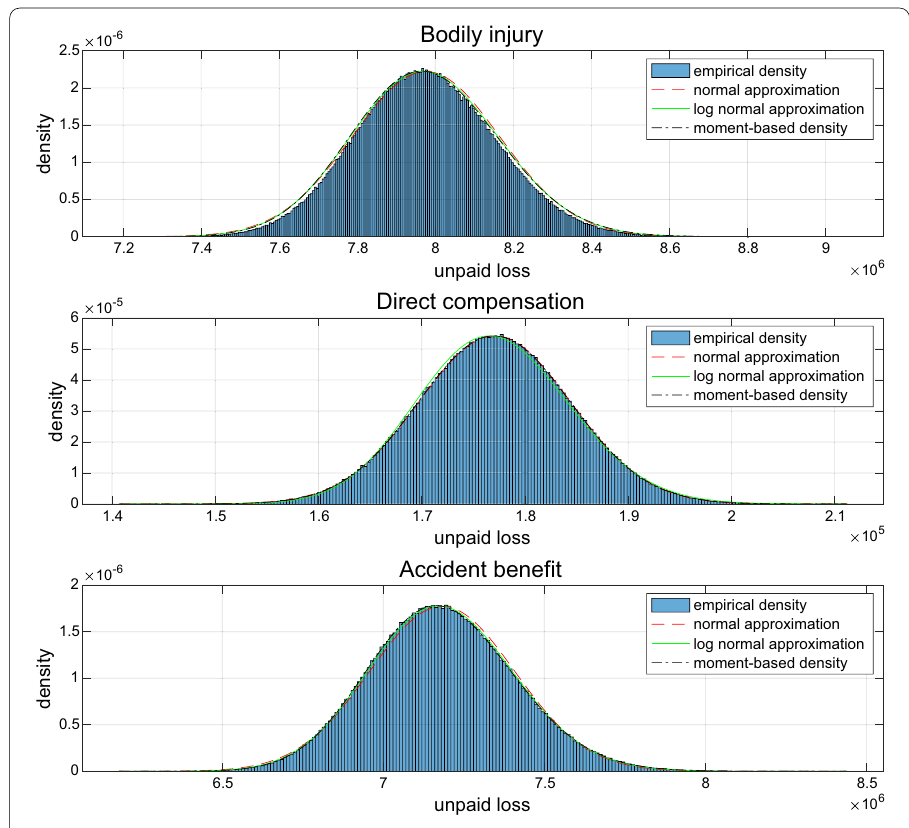
Fig. 2 Density of total unpaid